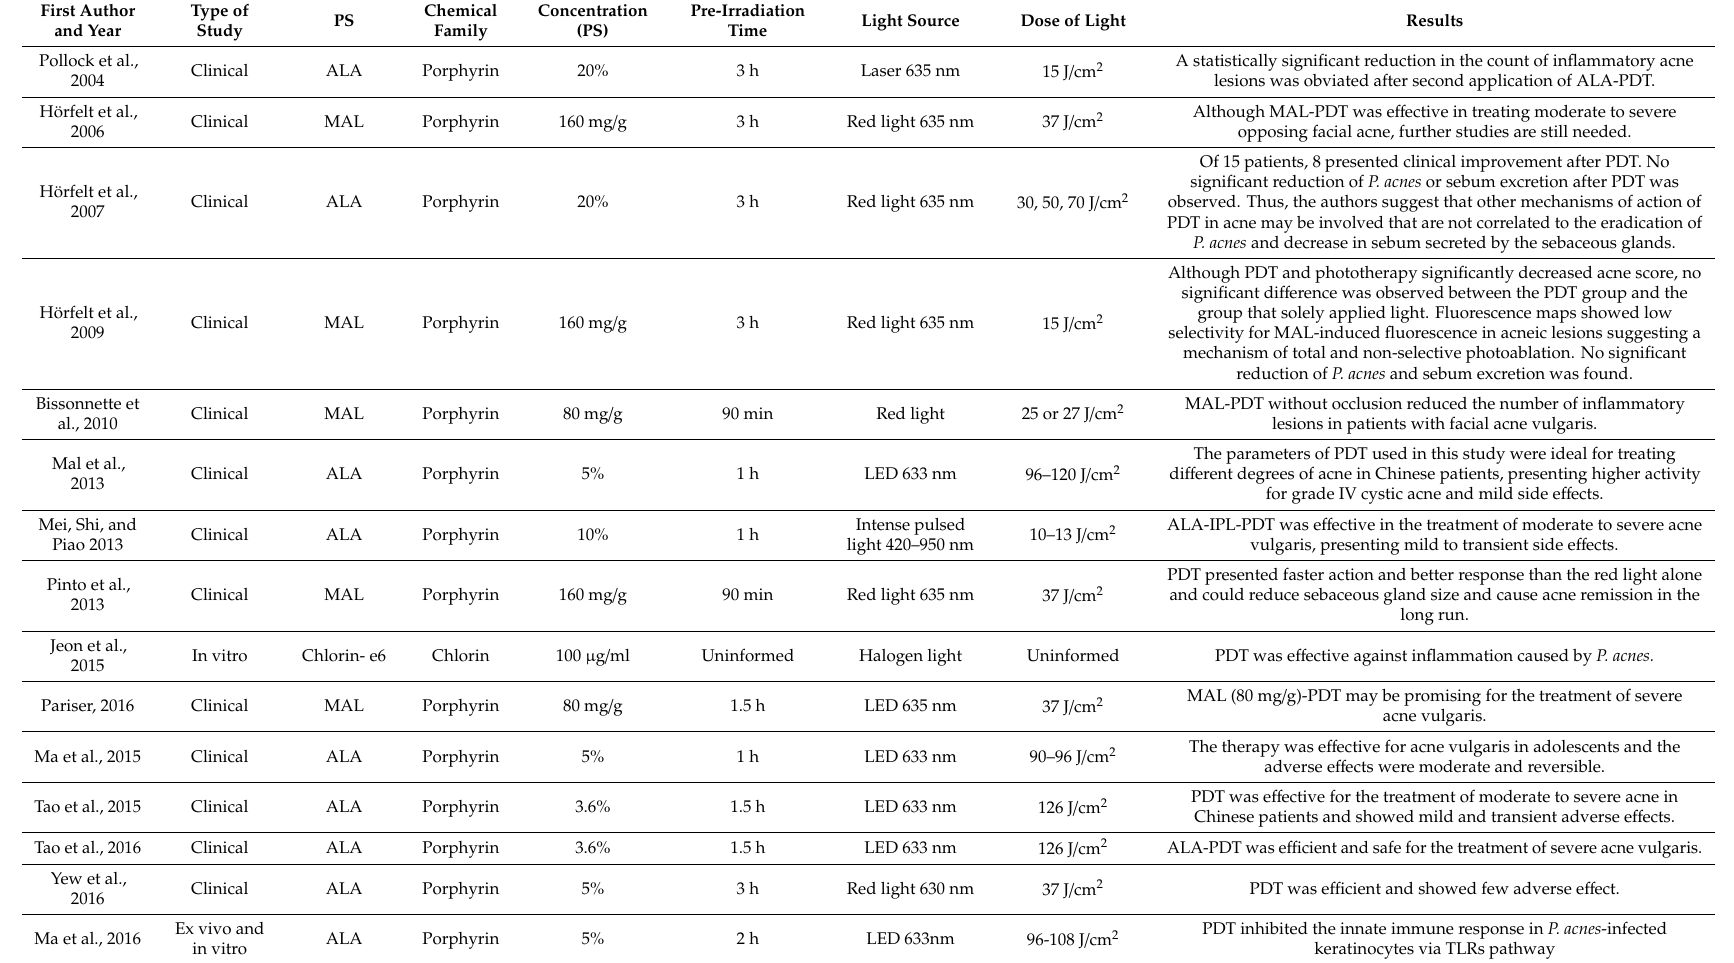
Table 2. Descriptions of the studies that used derivatives of porphyrins and chlorins for the treatment of acne